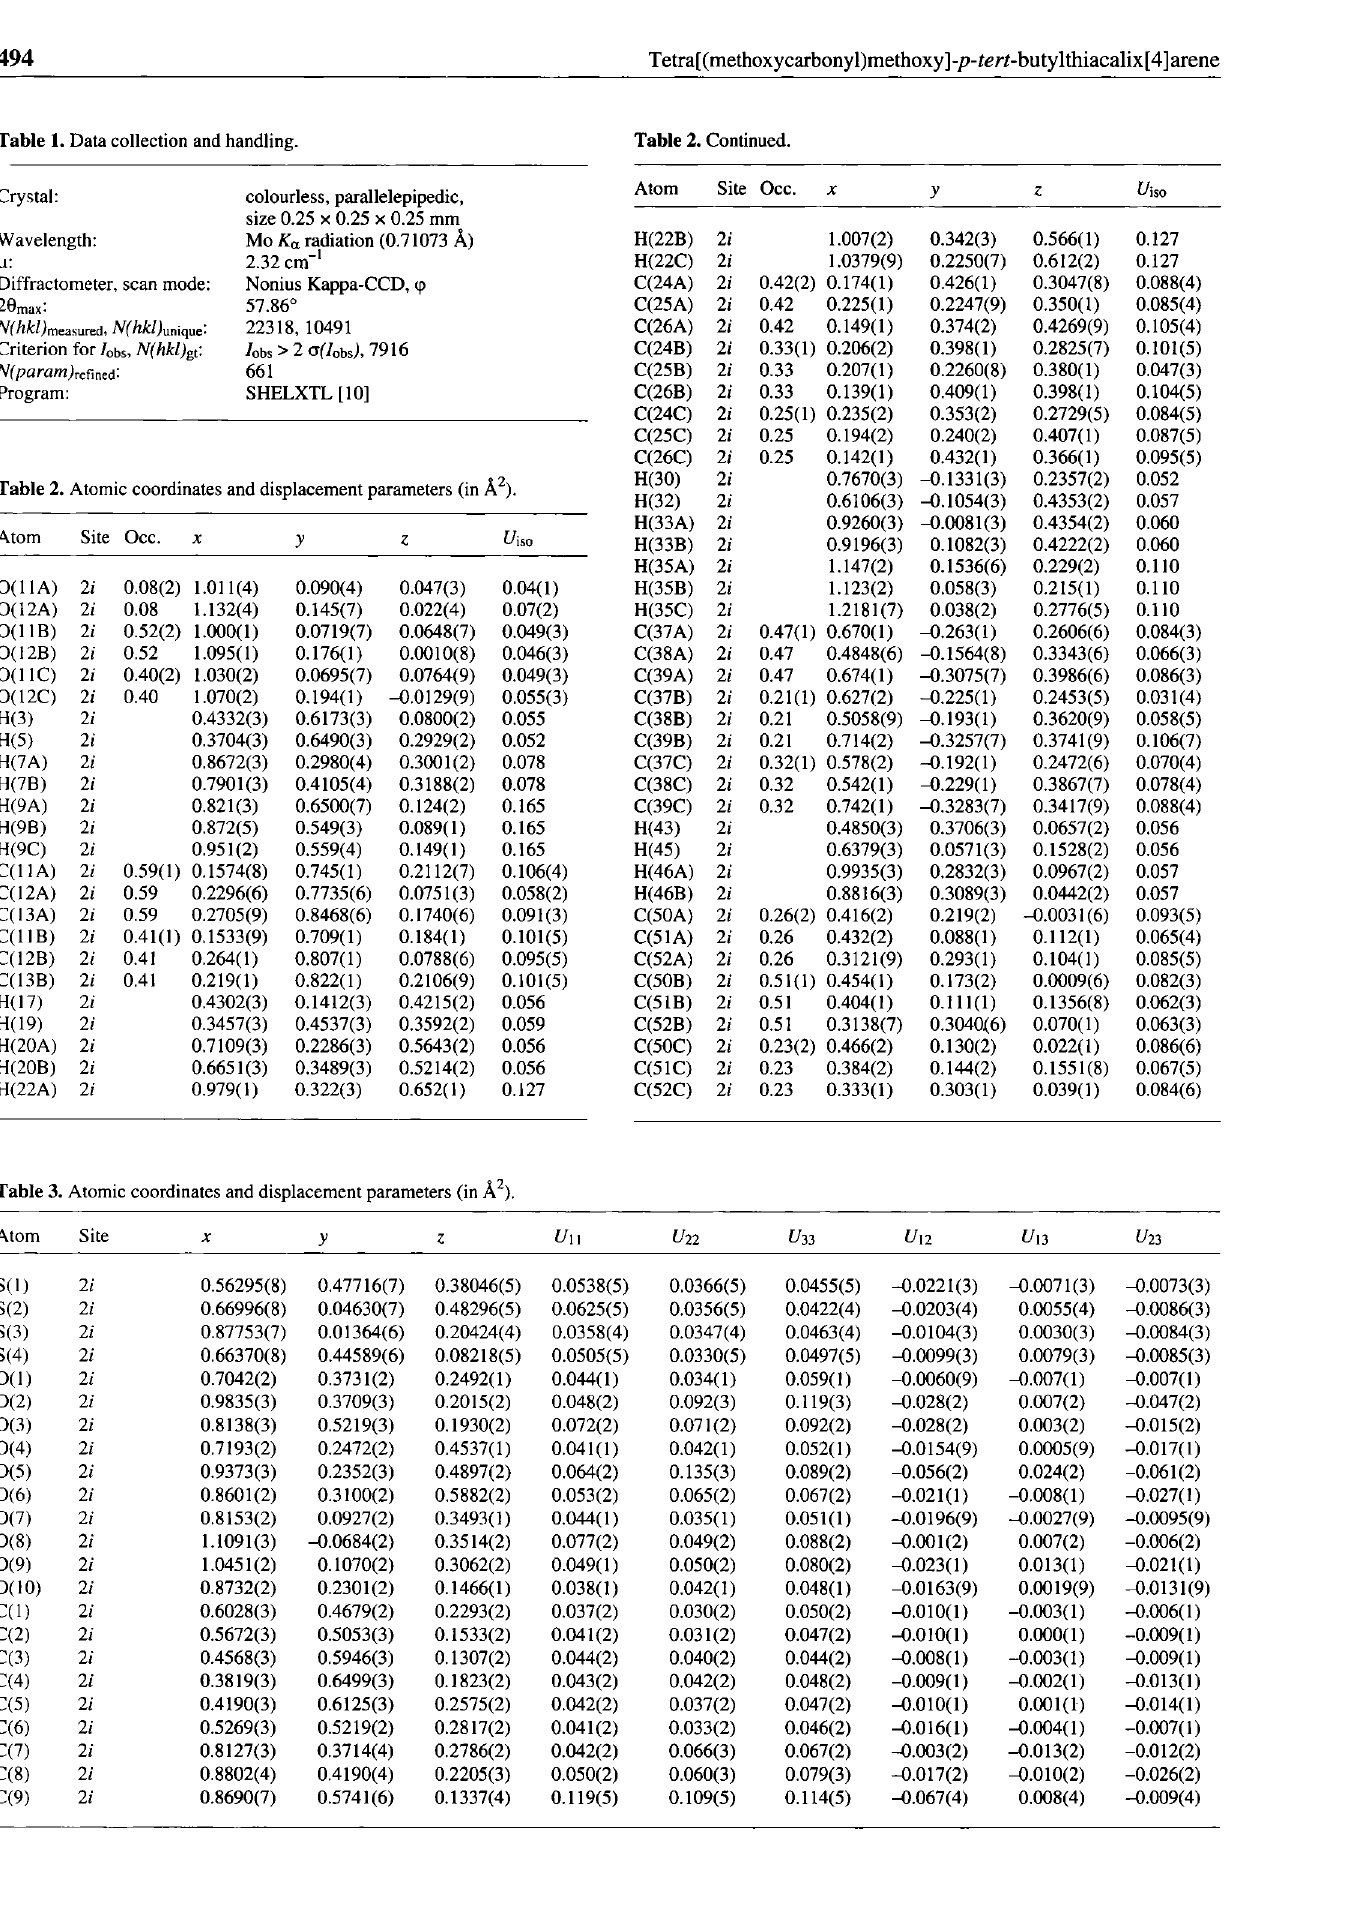
Table 1. Data collection and handling.